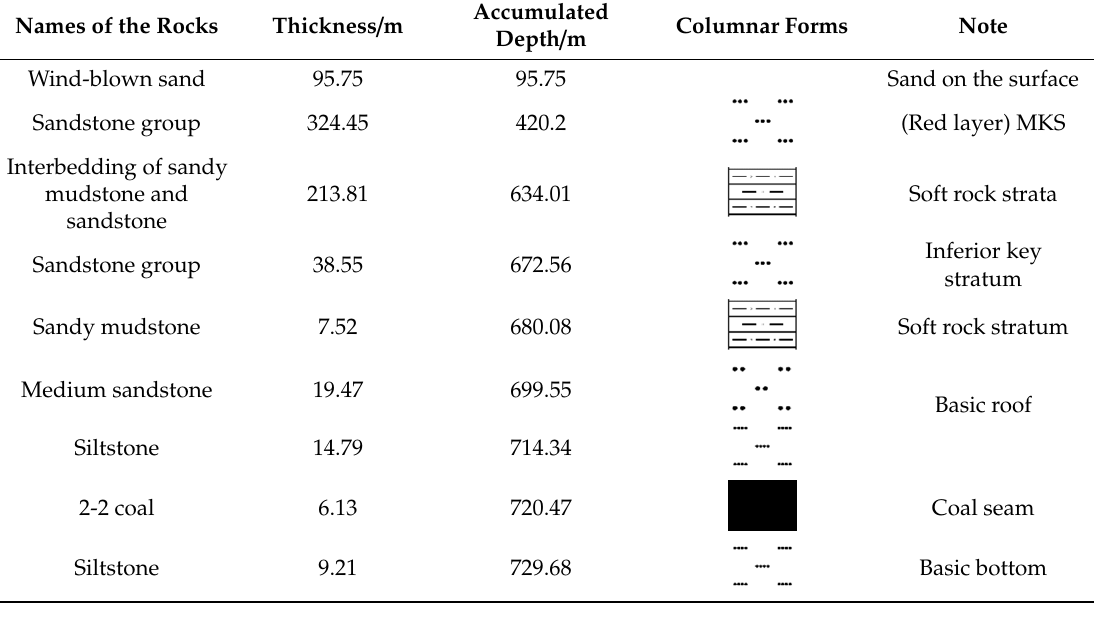
Table 1. Structural characteristics of rock strata above 2-2 coal seam.